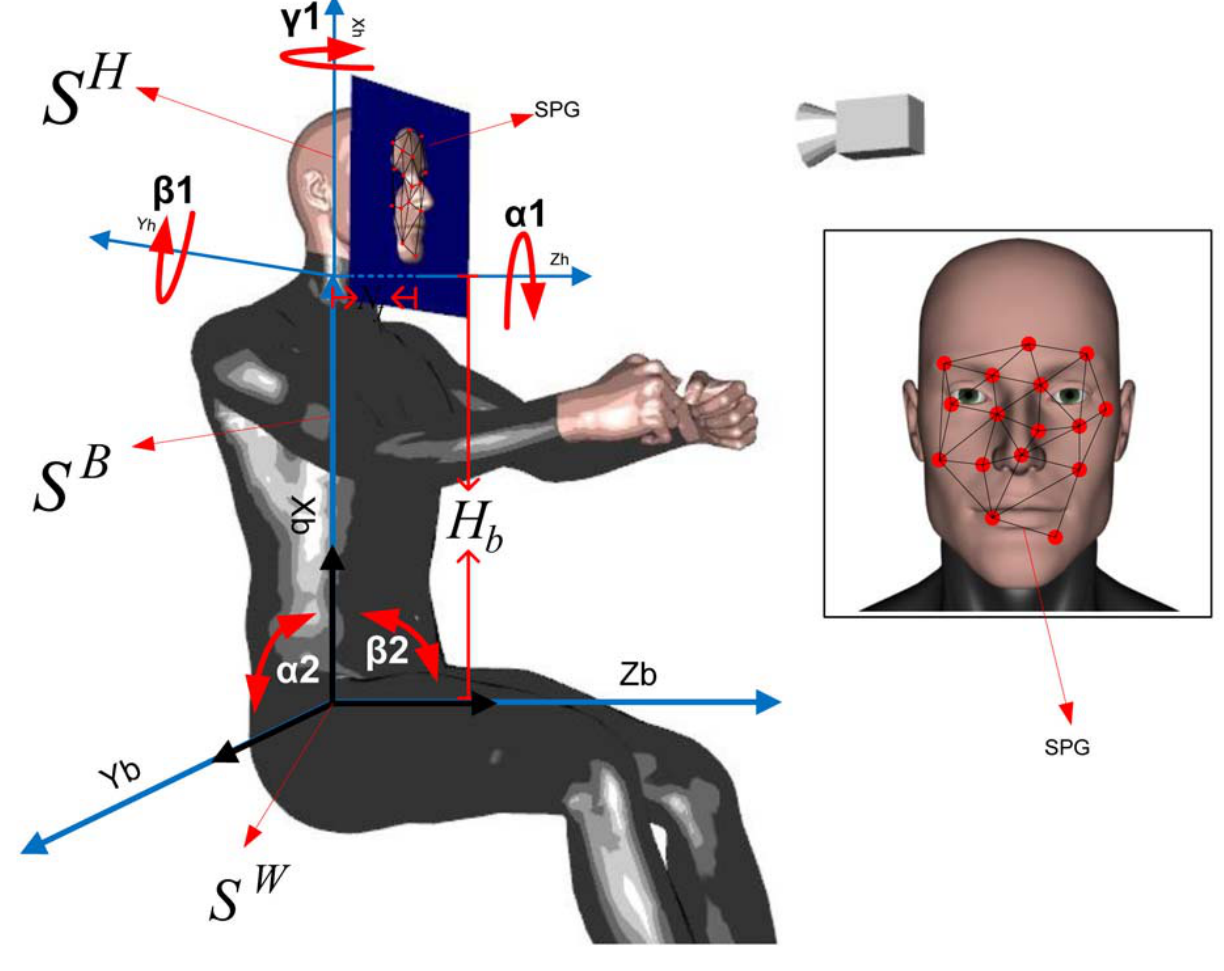
Figure 3. Driver’s kinematics and the salient points grid (SPG) fixed to the driver’s